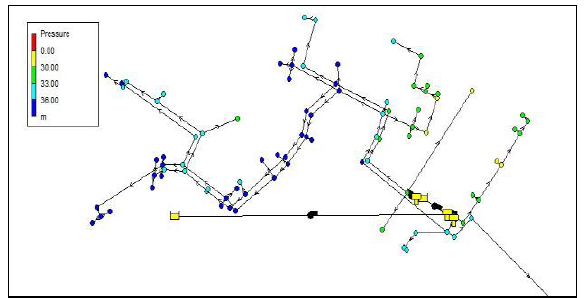
Figure 10 Network successfully satisfying fire demand at 12